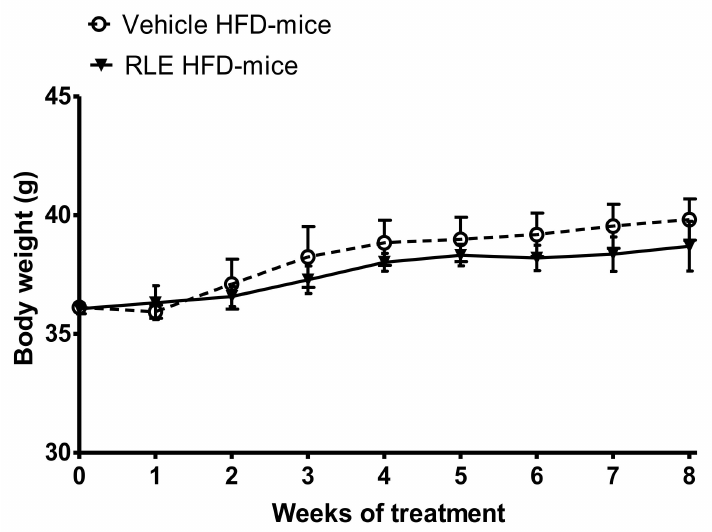
Figure 4. Effect of RLE diet supplementation on body weight increment in HFD-mice. RLE diet supplementation did not significantly reduce body weight increment in HFD-mice over the eight- week treatment. Data are means ± SEM of 9 to 12 mice per